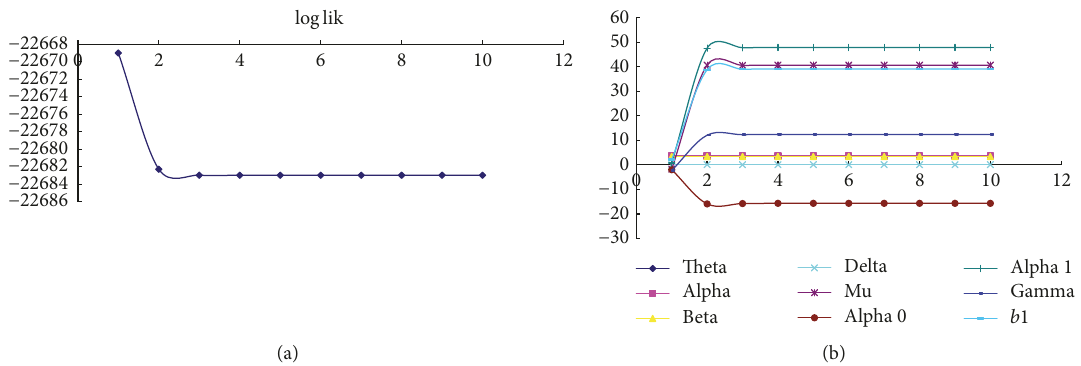
Figure1: Therelationship between likelihood function value ofDynamic EGARCH-L´evy-NIG model and cycle index (a)and therelationship between the parameter value of Dynamic EGARCH-L´evy-NIG model and cycle index